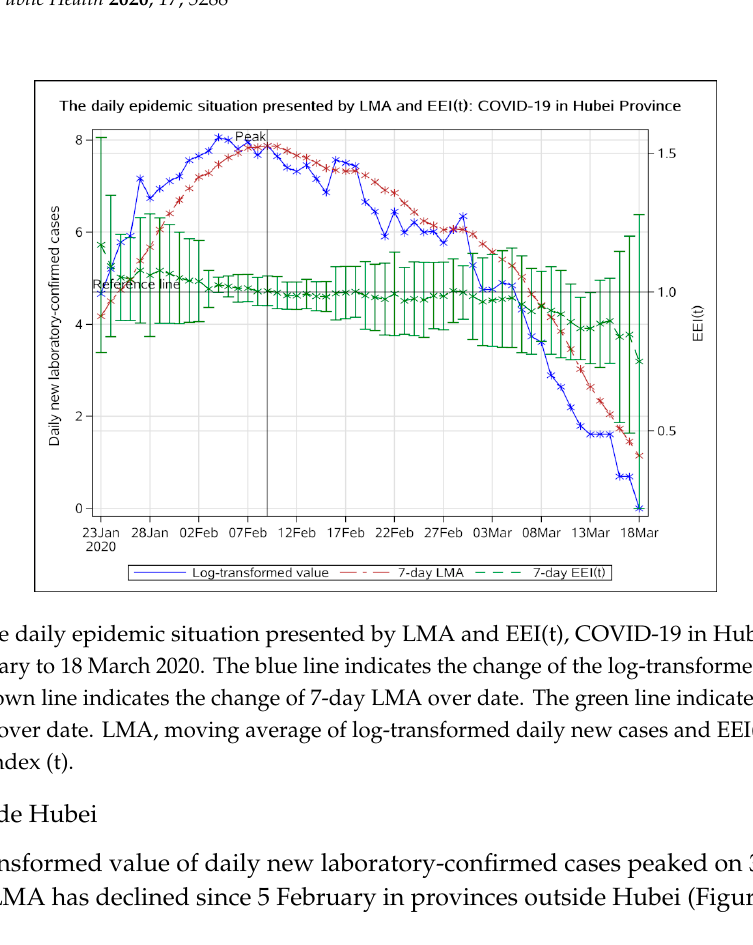
Figure 2. The daily epidemic situation presented by LMA and EEI(t), COVID-19 in Hubei Province, from 23 January to 18 March 2020. The blue line indicates the change of the log-transformed value over date. The brown line indicates the change of 7-day LMA over date. The green line indicates the change of the EEI(t) over date. LMA, moving average of log-transformed daily new cases and EEI(t), epidemic evaluation index (t).